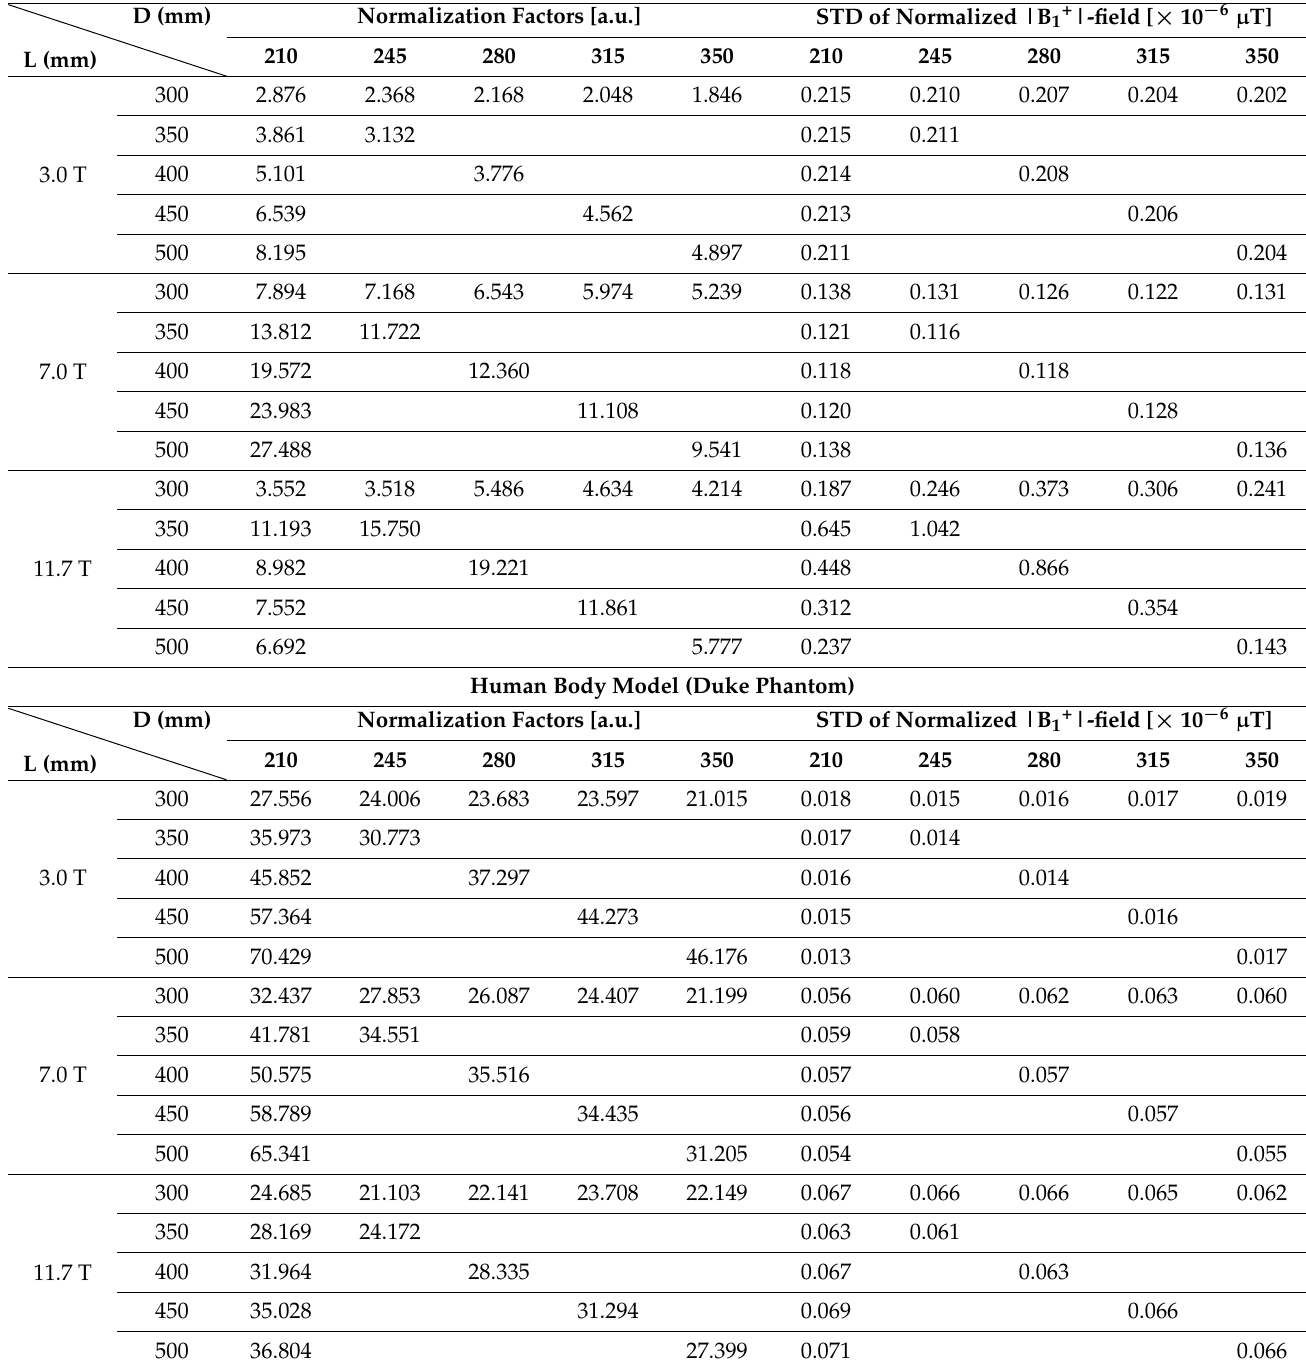
Table 2. STD values of the normalized |B 1+ |-field with normalization factors at a 3.0, 7.0, or 11.7 T MRI system. Cylindrical Phantom Model (Distilled Water) Normalization Factors [a.u.]